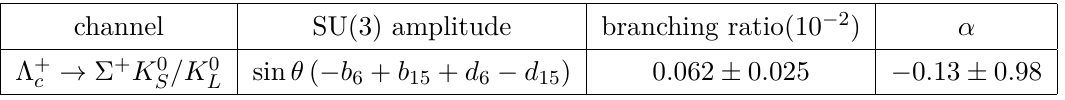
Table 1 . SU(3) amplitudes and predicted branching fractions (the third column) and polarization parameters (the fourth column) of anti-triplet charmed baryons decays into an octet baryon and an octet